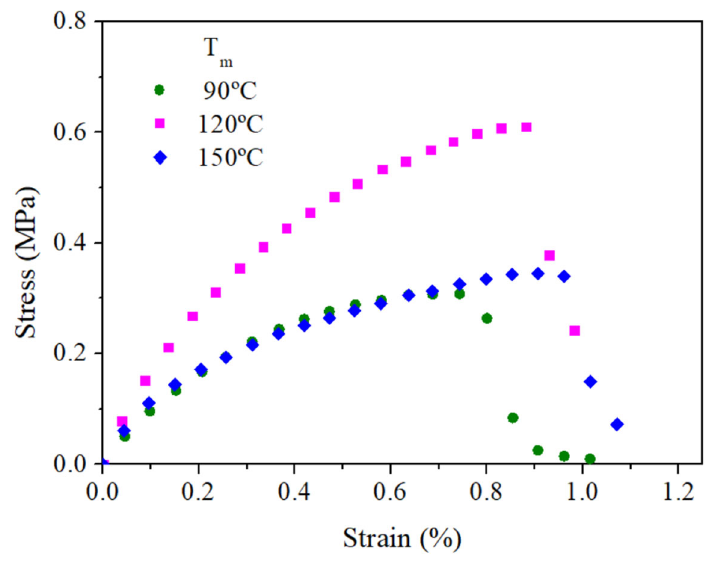
Figure 9. Tensile properties of bioplastics (RO/GLY: 70/30) processed at different molding temperature (90, 120 and 150 °C). Table 3. Mechanical parameters (Young’s modulus (E), maximum stress ( σ max ) and maximum strain ( ε max )) of bioplastics (RO/GLY: 70/30): for different molding temperature (90, 120 and 150 °C). Different letters within the same column parameter (WUC or SML) indicates significant differences ( p < 0.05).